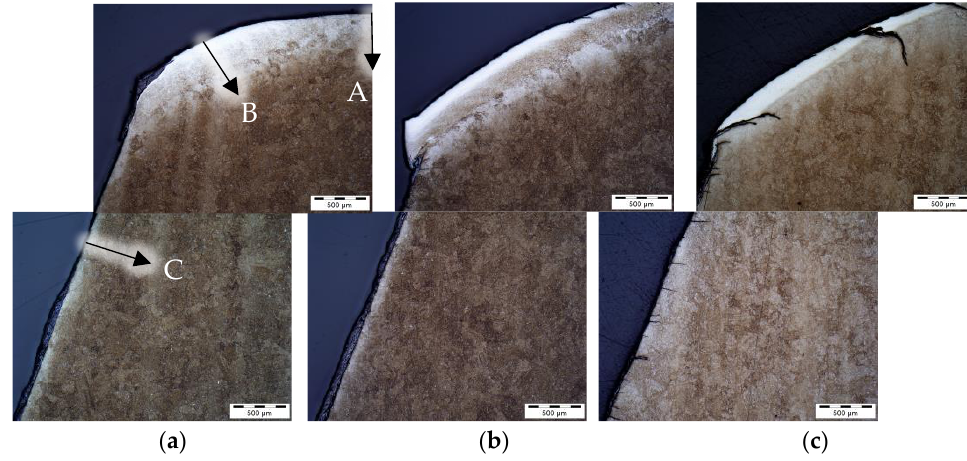
Figure 14. Stitched metallographic images of the tool edge layer of the non-nitrided tool steel H11 after ( a ) 100 cycles, ( b ) 500 cycles and ( c ) 2000 cycles.